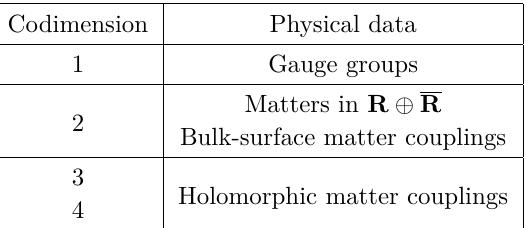
Table 1 . Singularities and the corresponding physical data of the low energy 2d N = (0 , 2) field